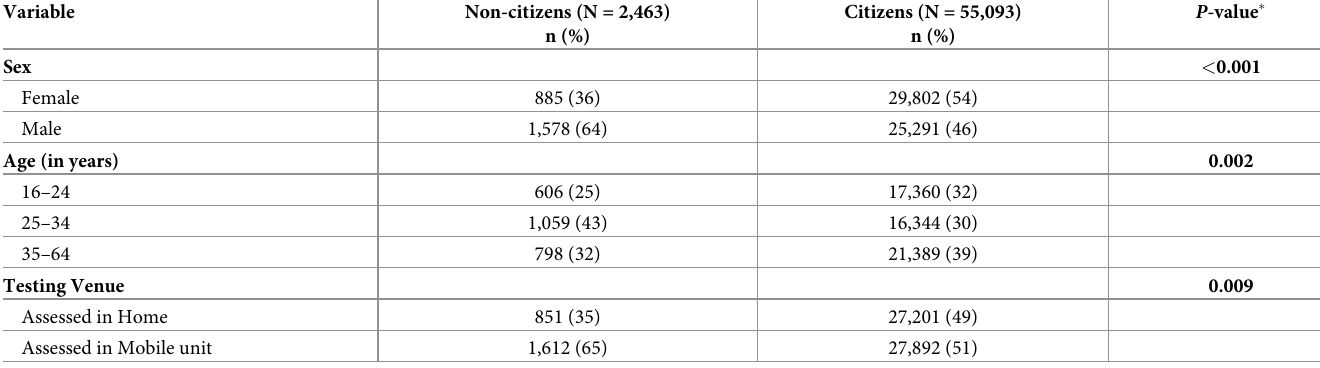
with only 4% refusing to be tested or show documentation of their HIV status. Overall, 4% citizens was higher than the refusal rate among citizens (6% vs. 4%; p = 0.028). Table 1 displays characteristics comparing non-citizens to citizens. A higher proportion of non-citizens were male (64%) compared to the proportion of citizens (46%; p = 0.001). The average age among non-citizens was slightly younger compared to citizens with the greatest